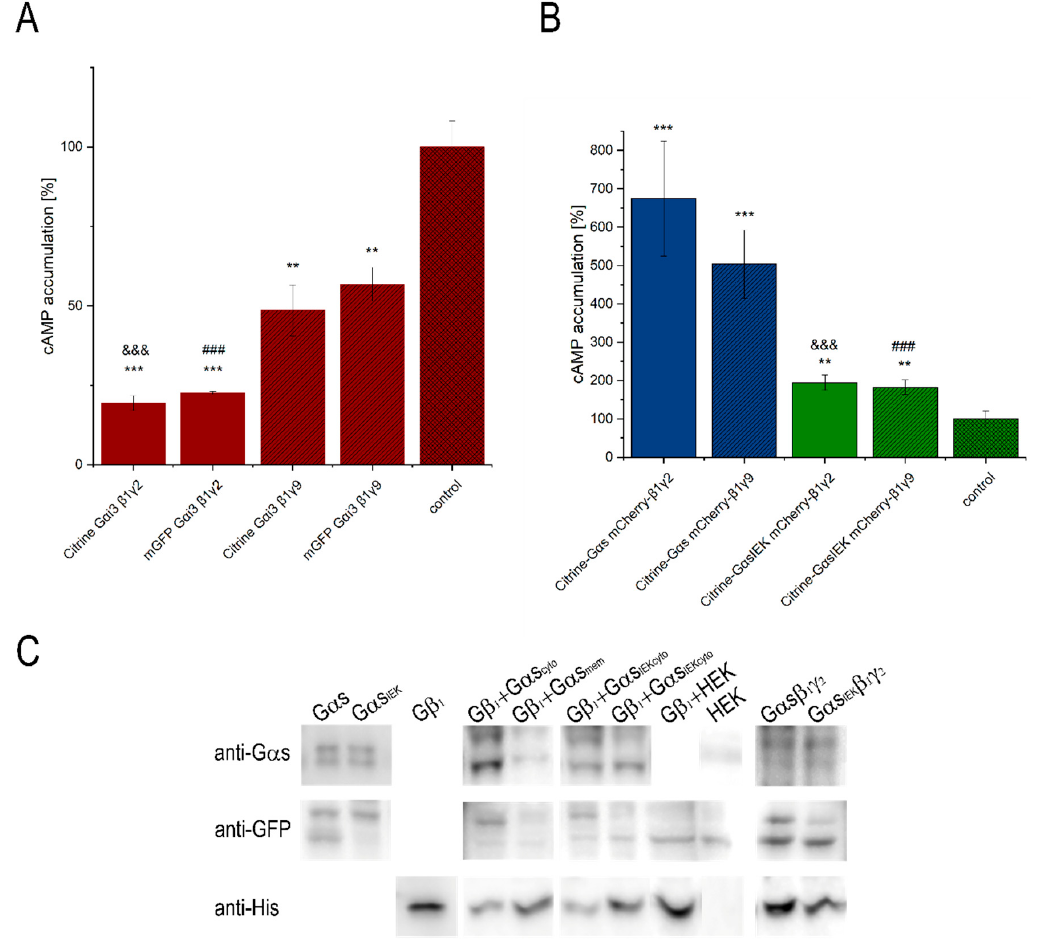
Figure 4. Effect of different G γ subunits on the production of cAMP. HEK 293 cells were